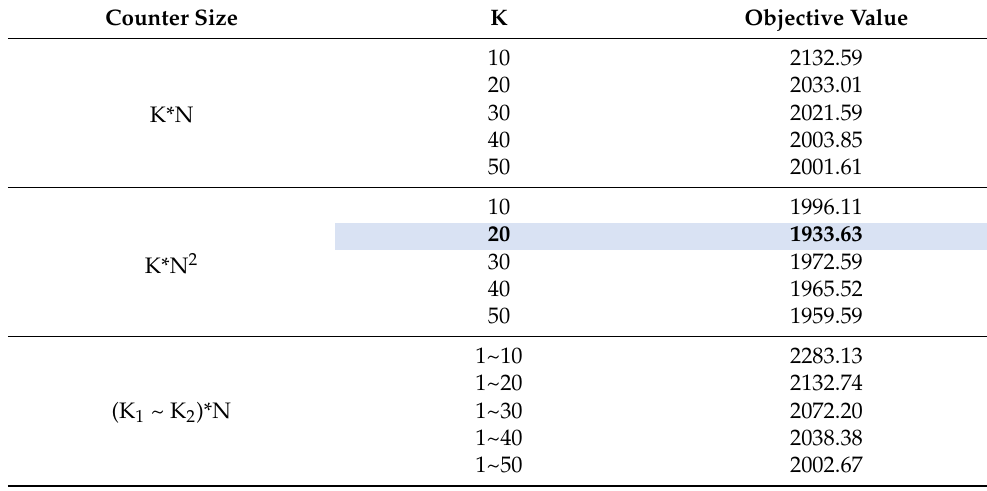
Table 1. Result of the VNS parameter